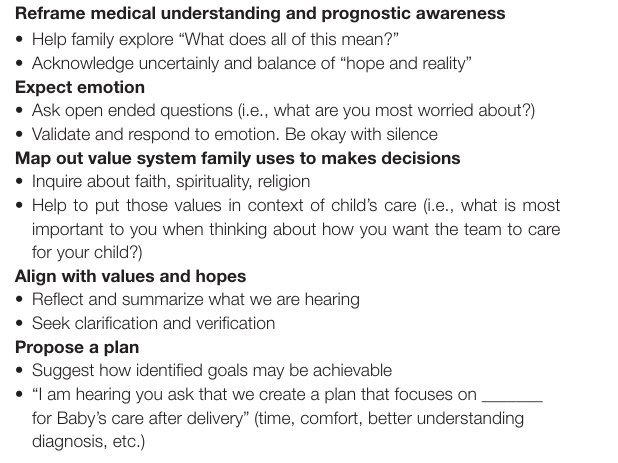
TABLE 2 | Exploring goals of care for families facing life-limiting fetal diagnoses [modified REMAP framework (80)]. Reframe medical understanding and prognostic